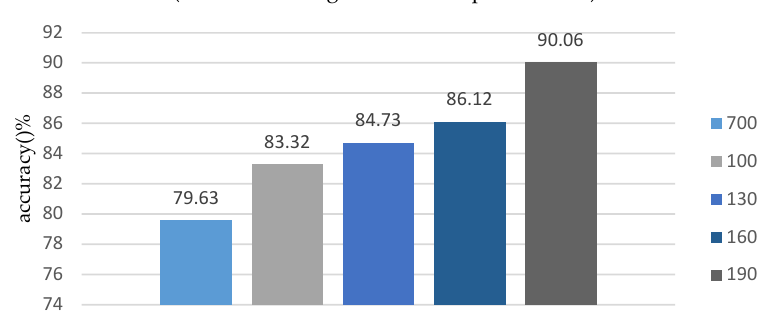
Figure 9. As the number of original real samples used to train unidimensional ACGAN changes, the average accuracy of unidimensional DenseNet changes, and the number of generated samples is fixed.